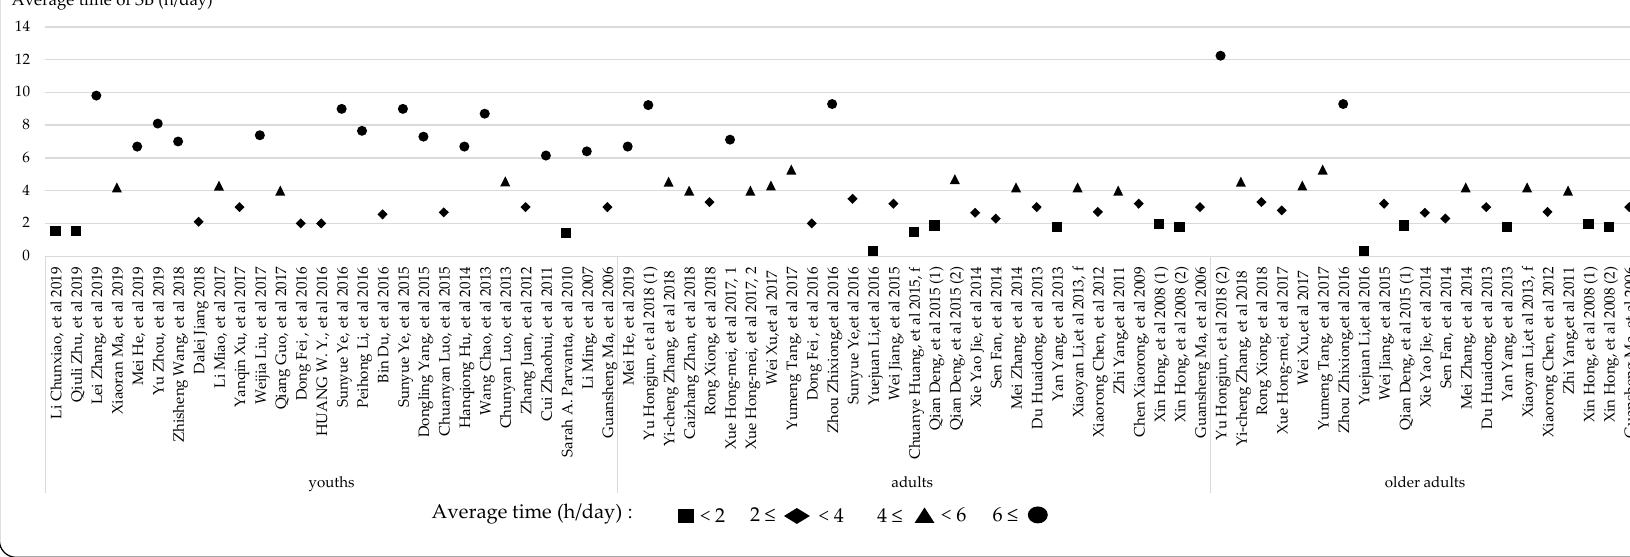
Figure 4. The average duration (h/day) engaged in SB (in the form [198]) (abbreviations: m = male; f = female; youths < 18 years; 18 years ≤ adults < 65 years; older adult ≥ 65 years; Xue Hong-Mei, et al. 2017, 1 = 20–40 years [196]; Xue Hong-Mei, et al. 2017, 2 = 41–55 years [196]).